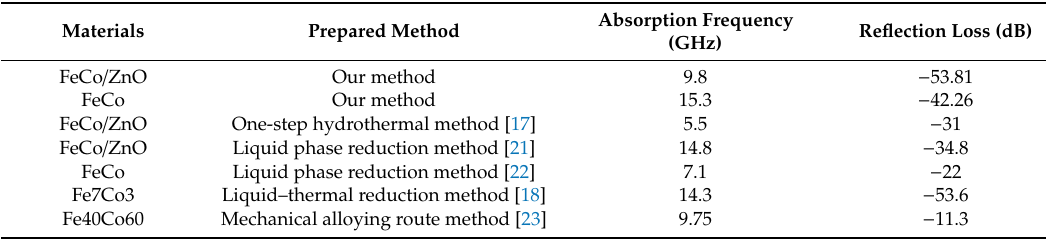
Table 2. Optimal microwave absorption properties of FeCo and FeCo / ZnO composites reported in the di ff erent